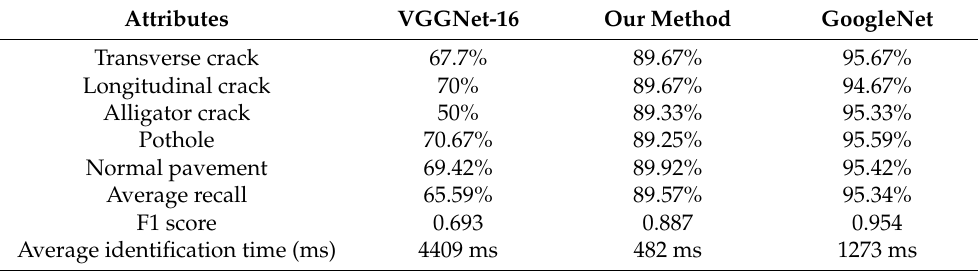
Table 2. The recall rate, F1 score, and average recognition time of this method and the other two classification methods for various types of damage on the